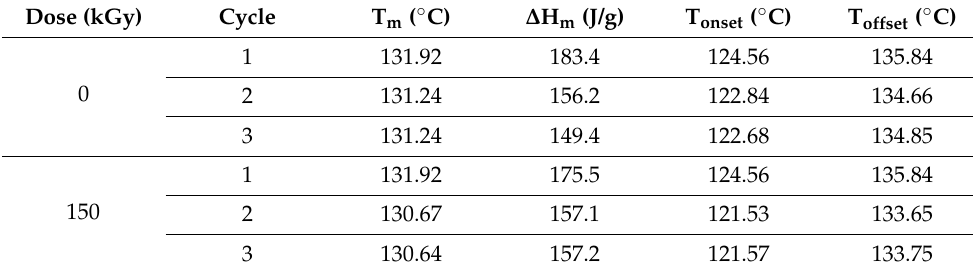
Table 8. Kinetic parameters of the melting curve of (CB + Gr)/HD.